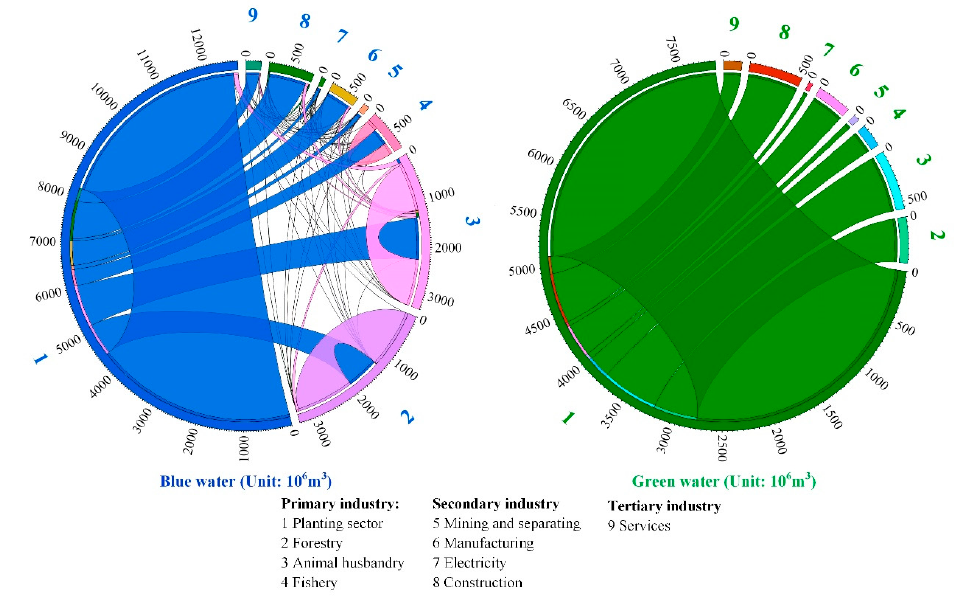
ff erent economic sectors in